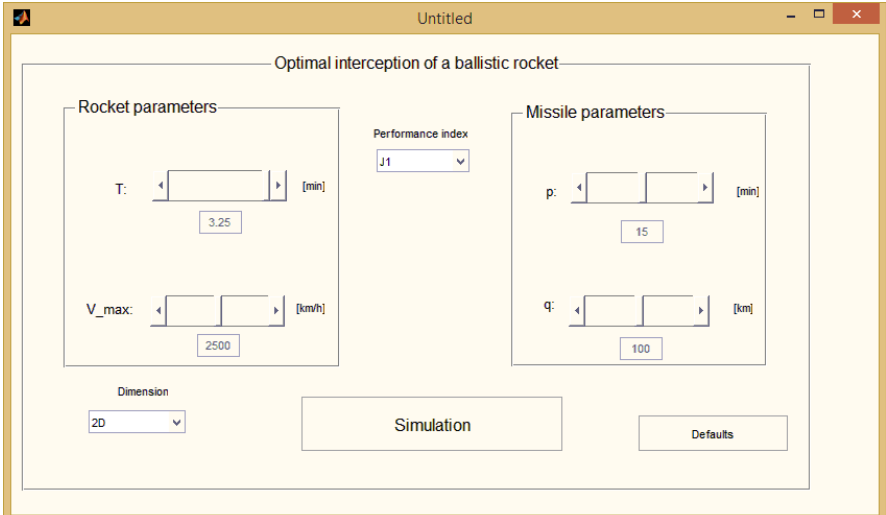
Figure 10. Main menu of the software